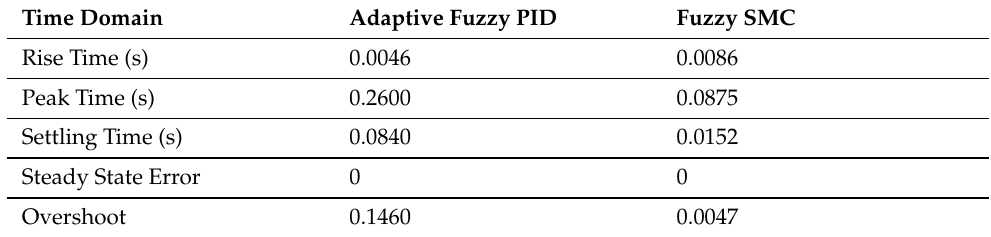
Table 9. Comparison of